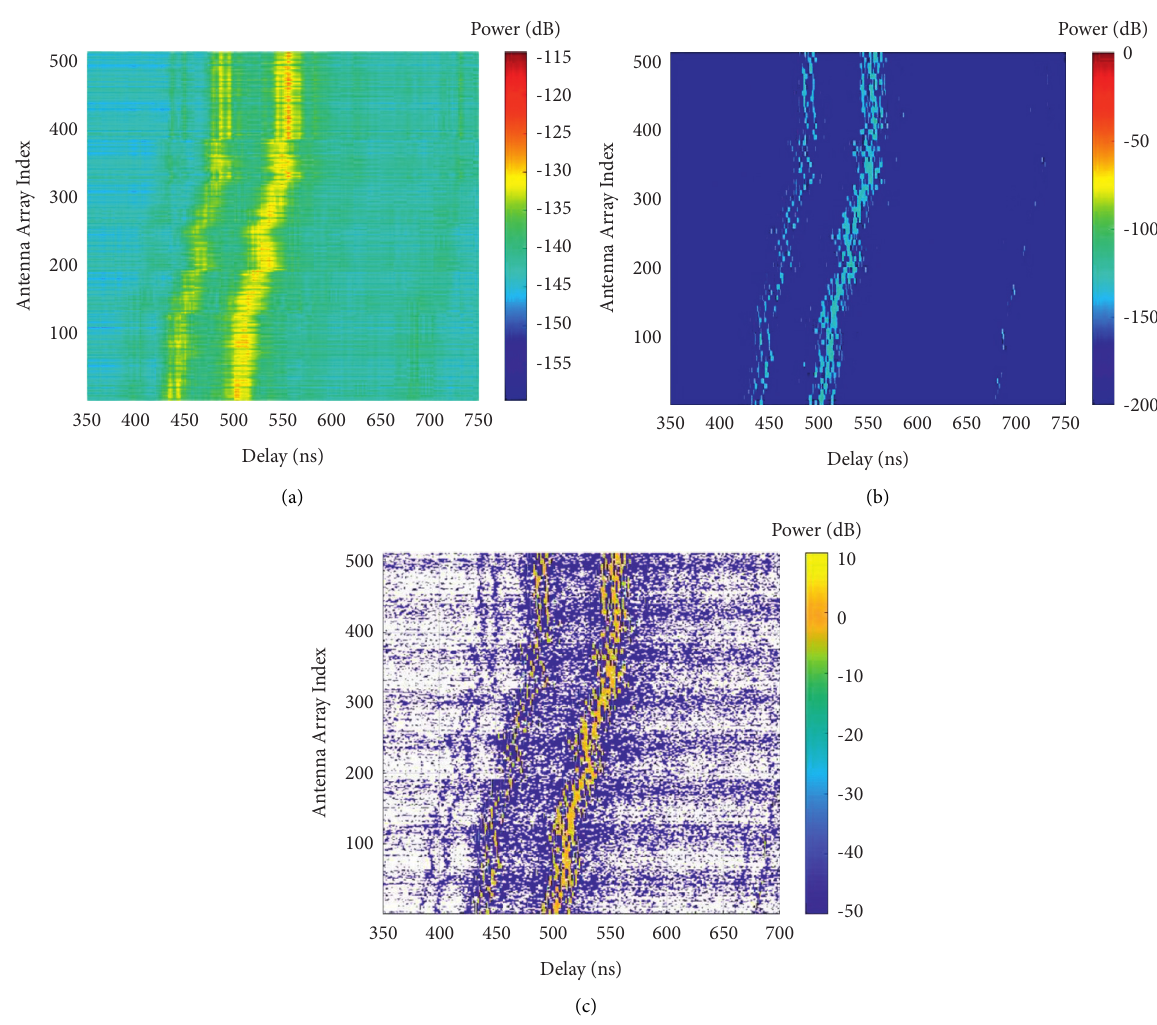
Figure 6: PDP of Rx-27 in NLOS scenarios. (a) Measured PDP of Rx-27, (b) reconstruction PDP of Rx-27, (c) residual PDP of Rx-27.